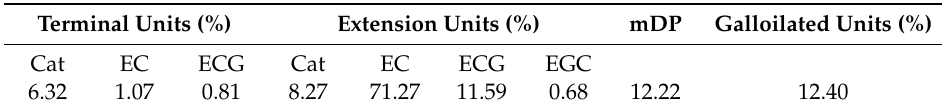
Table 6. Characteristics and structural composition (percent in moles) of procyanidin fraction from optimal stem PLE